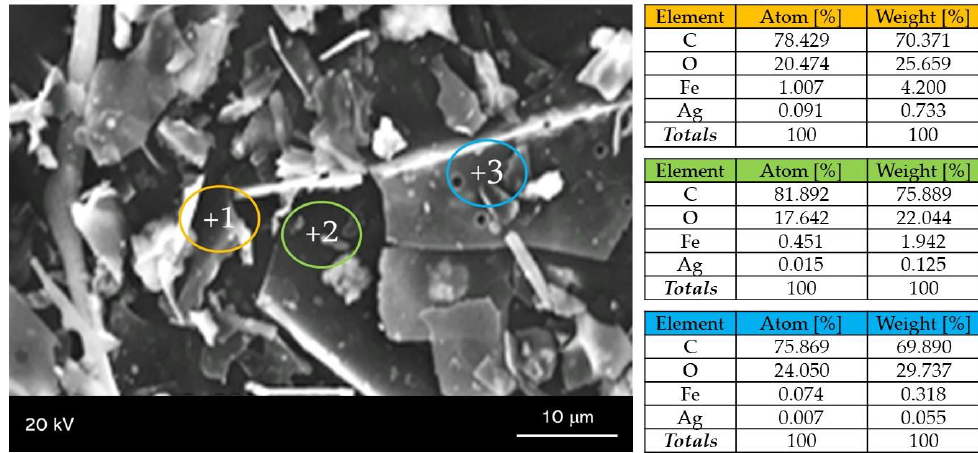
Figure 9. SEM-EDS (Scanning Electron Microscopy with Energy Dispersive Spectroscopy) analysis of Fe 3 O 4 @Ag nanoparticles.